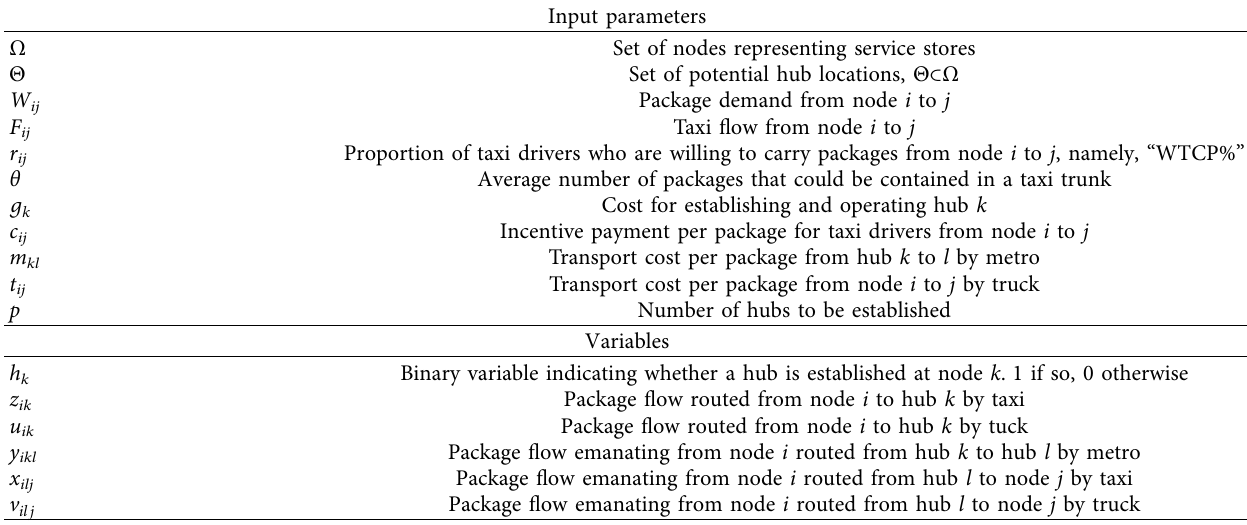
Table 1: Summary of